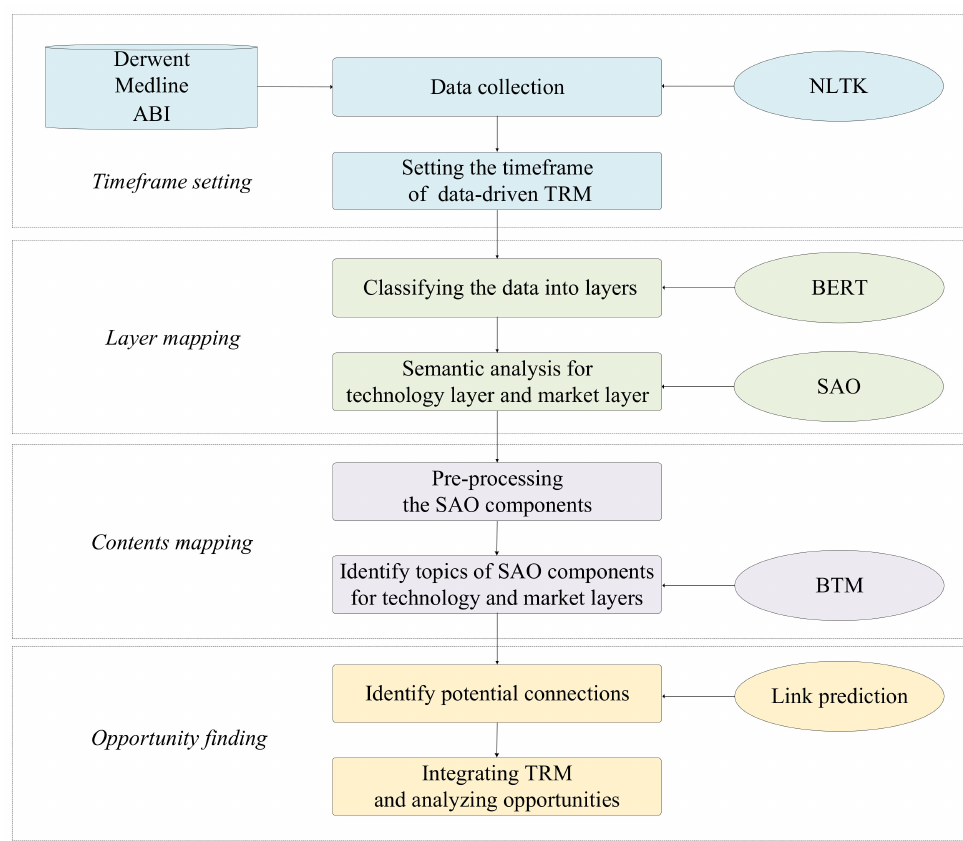
Figure 2. Research